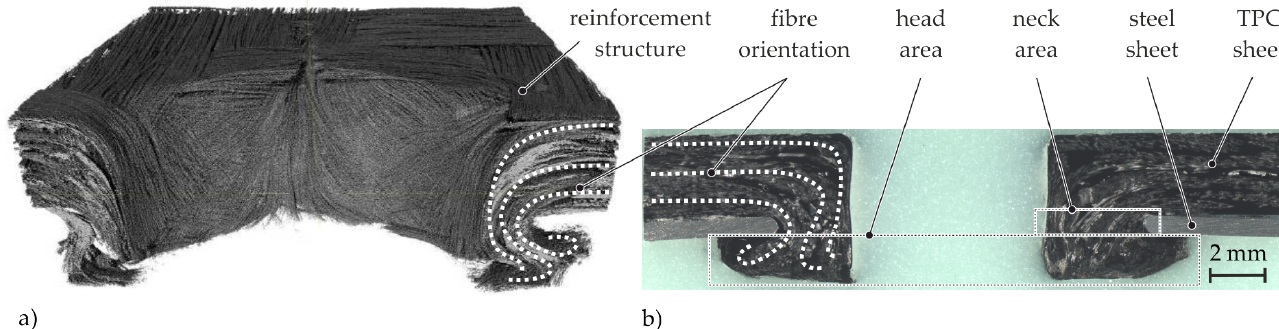
Figure 10. ( a ) CT analysis of the TPC of a thermoclinched joint and ( b ) micrograph analysis of a Thermoclinching